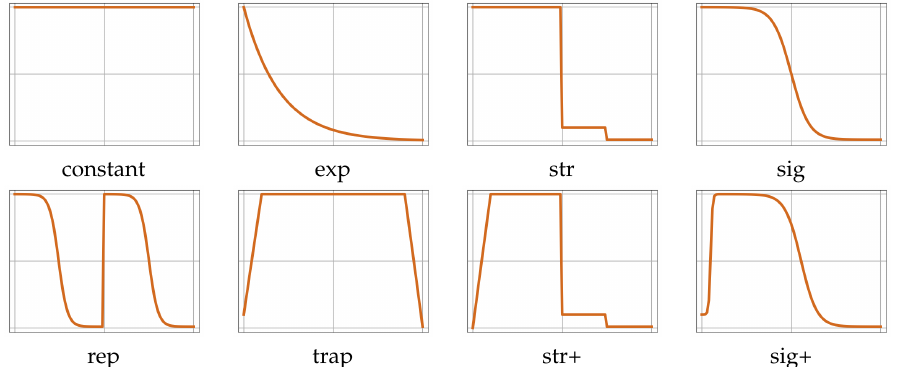
Figure 1. ( y -axis) Learning rate over ( x -axis) epochs by ( top row ) conventional annealing meth- ods: constant learning rate η = 0.1, exponential function (exp) [55], staircase (str) [40] with η = 0.1,0.01,0.001, and sigmoid function (sig), and ( bottom row ) warmup methods: twice-repeated sigmoids (rep), trapezoid with 10%-epoch warmup (trap) [60], staircase with the warmup (str+), and our sigmoid with the warmup